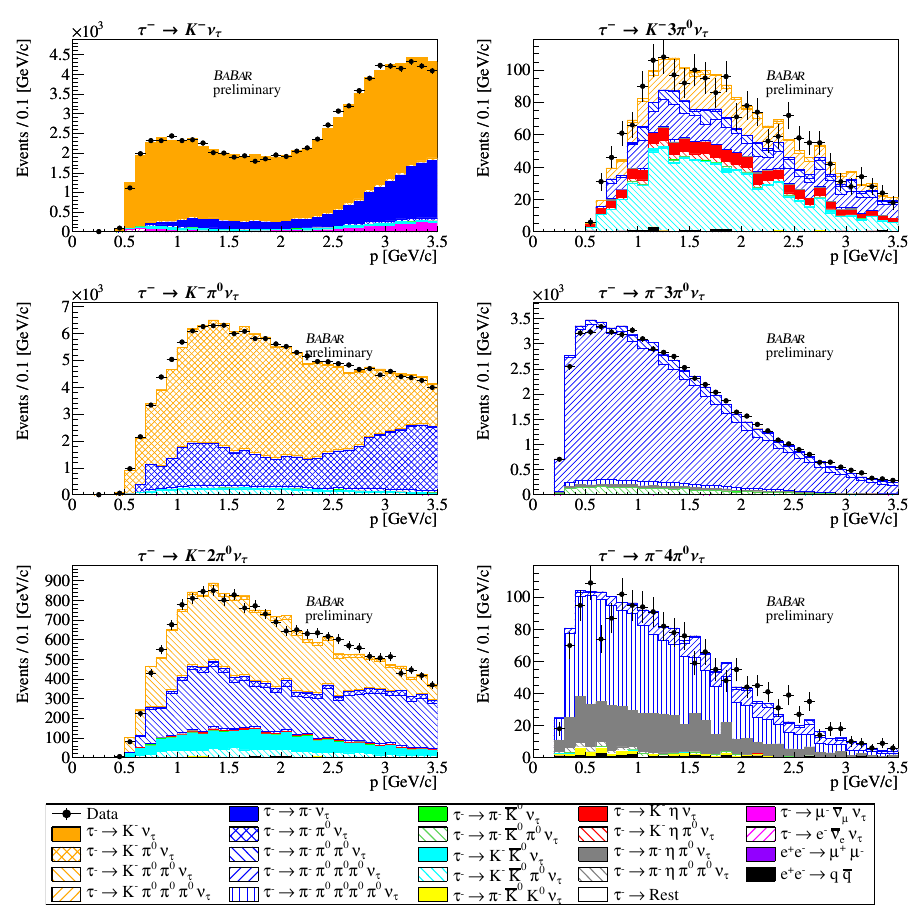
Figure 3. Laboratory-frame momentum of the track in the signal hemisphere for the selected candidates of the six signal modes. Data points are overlaid onto cumulated histograms representing simulated